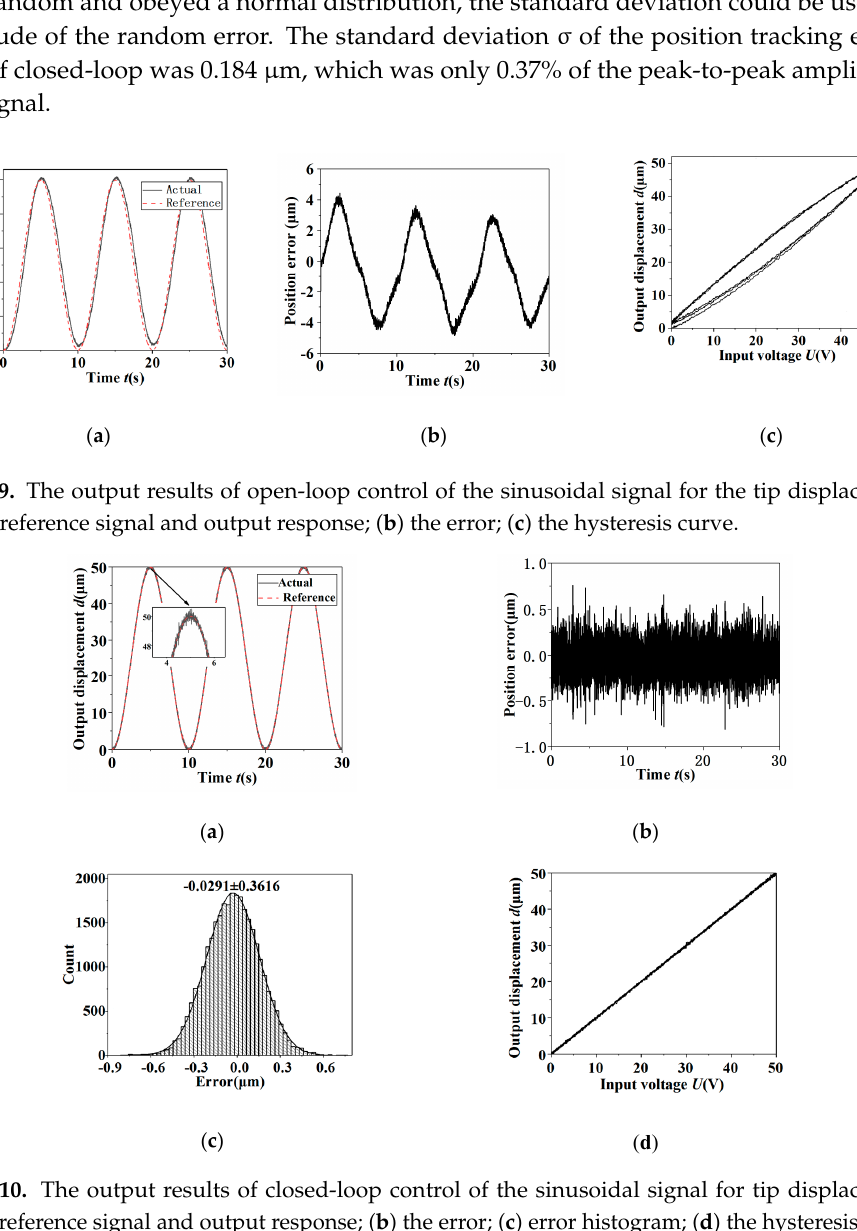
Figure 10. The output results of closed ‐ loop control of the sinusoidal signal for tip displacement. ( a ) The reference signal and output response; ( b ) the error; ( c ) error histogram; ( d ) the hysteresis curve.